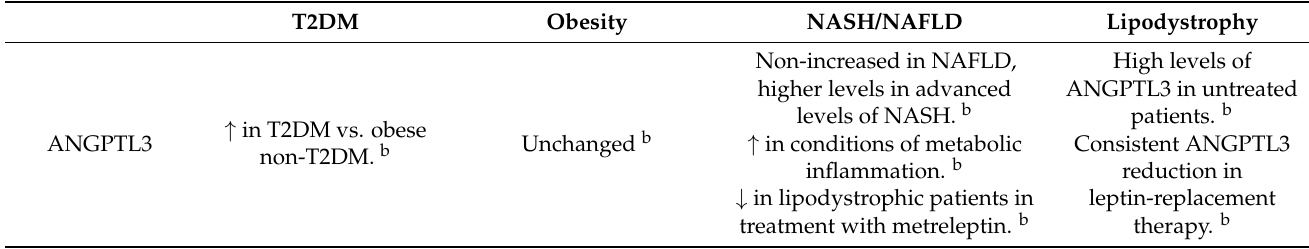
Table 1. Serum ANGPTLs change in metabolism-related diseases.